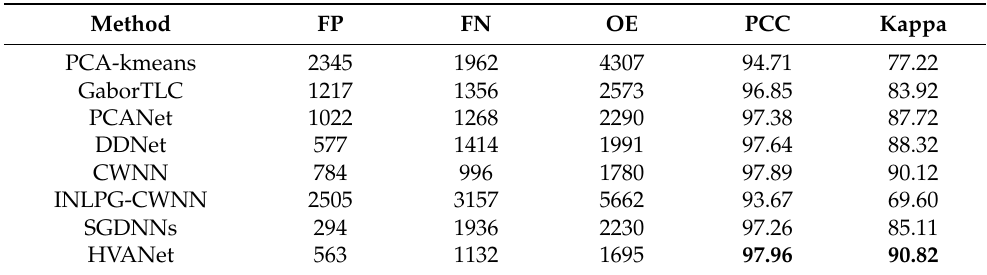
Table 11. The average evaluation criteria of different methods for the three